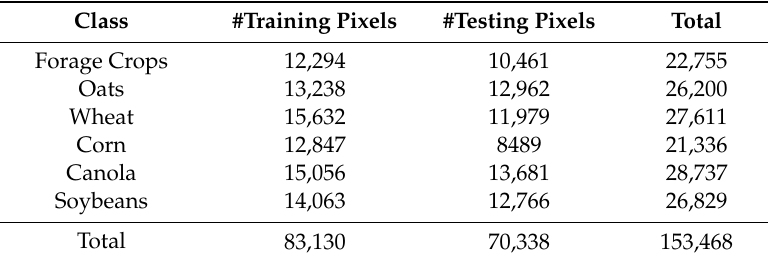
Figure 1. The geographic location of the study area. Table 1. Testing and training pixel counts for each crop in this study.